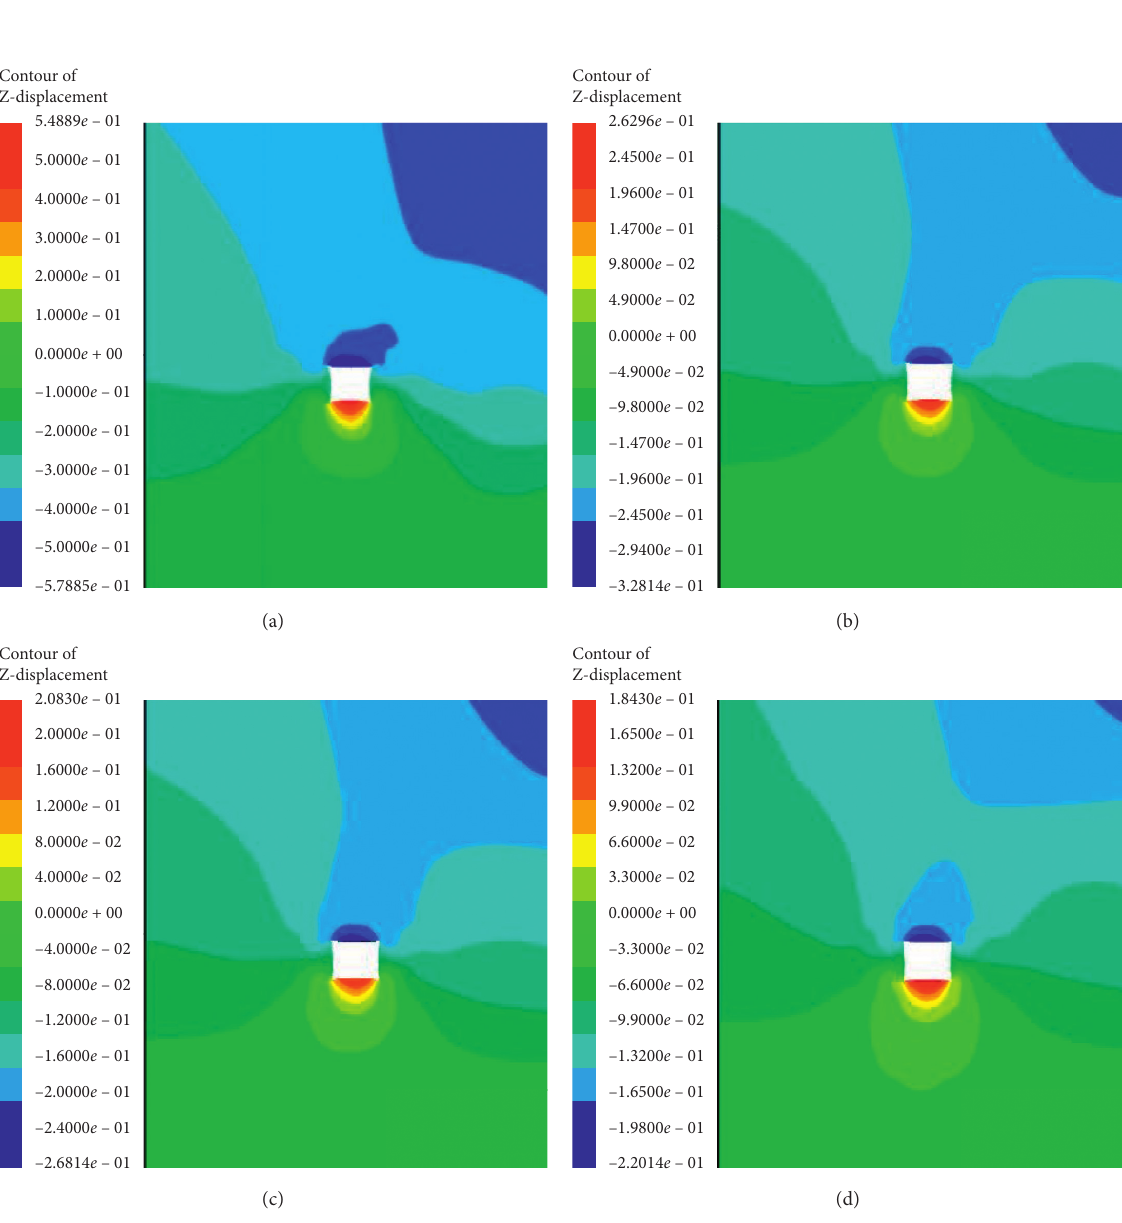
Figure 11: Deformation of the roof and floor: (a) cutting height 0m; (b) cutting height 10m; (c) cutting height 12m; and (d) cutting height